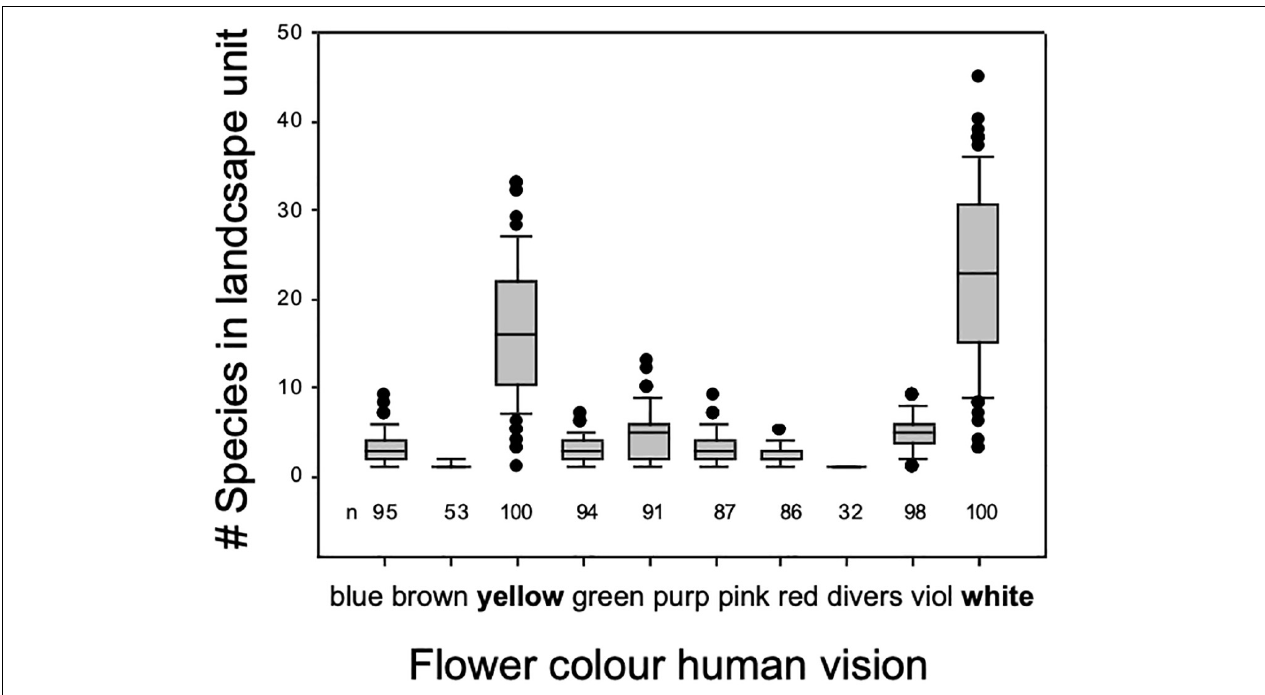
FIGURE 5 | Number of plant species displaying flower color by 10 categories as sensed by human vision in a typical semi-natural, montaneous landscape in central Europe. Data are based on 100 plots of 100 m × 100 m systematically arranged with a 4 km × 4 km landscape unit a calcareous bedrock harboring mesic grasslands, small deciduous forests, hedges, rocky outcrops, partly grazed, partly mown, partly logged in the Franconian Swiss, Bavaria, Southern Germany regions. Most flowering forbs in this diver’s cultural landscape are perceived yellow or white by humans.